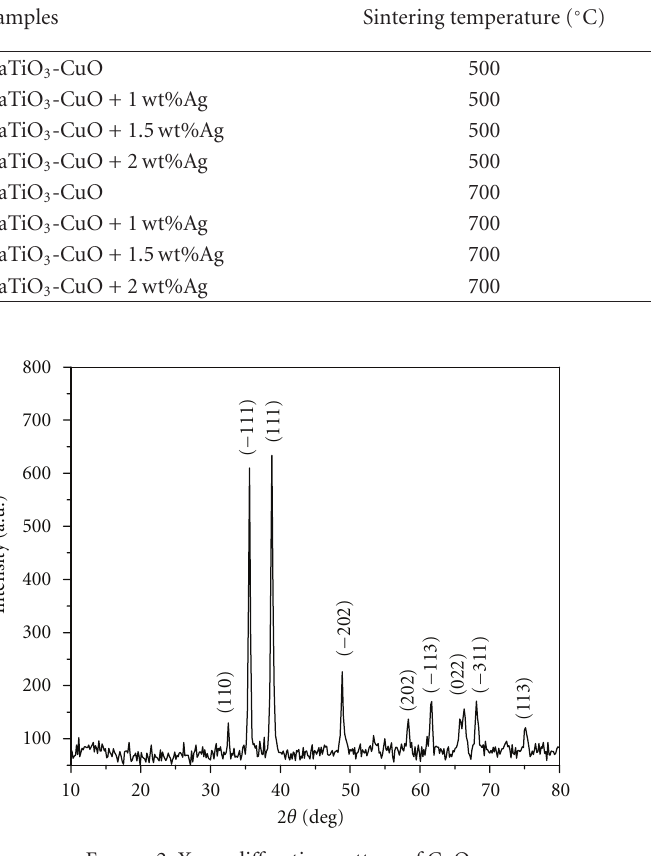
Figure 2: X-ray di ff raction pattern of CuO.